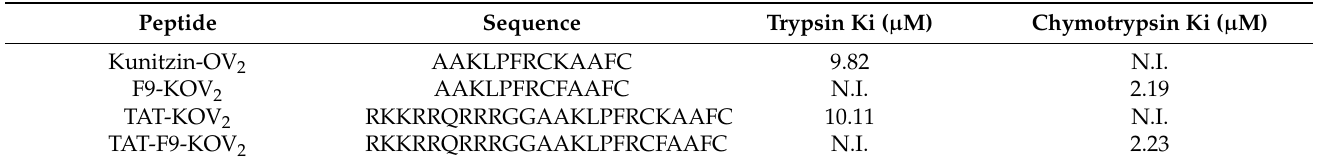
Table 2. The Ki value of kunitzin-OV 2 , F9-KOV 2 , TAT-KOV 2 , and TAT-F9-KOV 2 against trypsin and chymotrypsin. “N.I.” indicates no inhibitory effect.